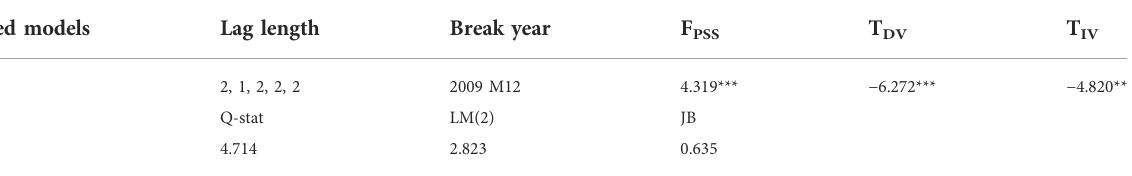
TABLE 2 BARDL cointegration analysis results.